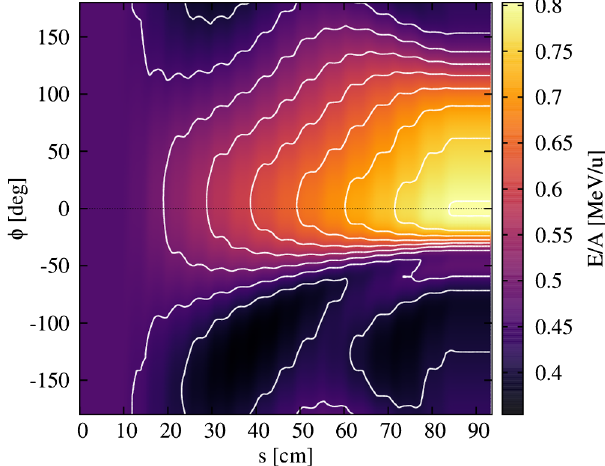
FIG. 4. TRANSOPTR computed reference particle E=A for IH Tank-3, using the field shown in Fig. 3, center. The horizontal axis is the s -coordinate along the cavity ’ s central optical axis, s Þ . Contours where the spatial component of the field is E n ð (white) delineate constant reference particle energy. The rf scaling parameter has been kept constant for each cavity phase ϕ . The zero-degree phase causes monotonous energy increase along Tank-3. At the end of the cavity, the resulting E=A vs ϕ response is characteristically nonsinusoidal, instead featuring a sharp dropoff in E=A to phases negative of zero-degree. Phases above zero-degree cause a more gentle decrease in energy, until the output falls below the injection E=A of 0 . 461 MeV =u . This characteristic profile is useful to establish a calibration between beam-based measurements and model computations, relating the field scaling in Eq. (8) and the rf amplitude parameter in the s Þ control system [38], given a computed field profile E n ð